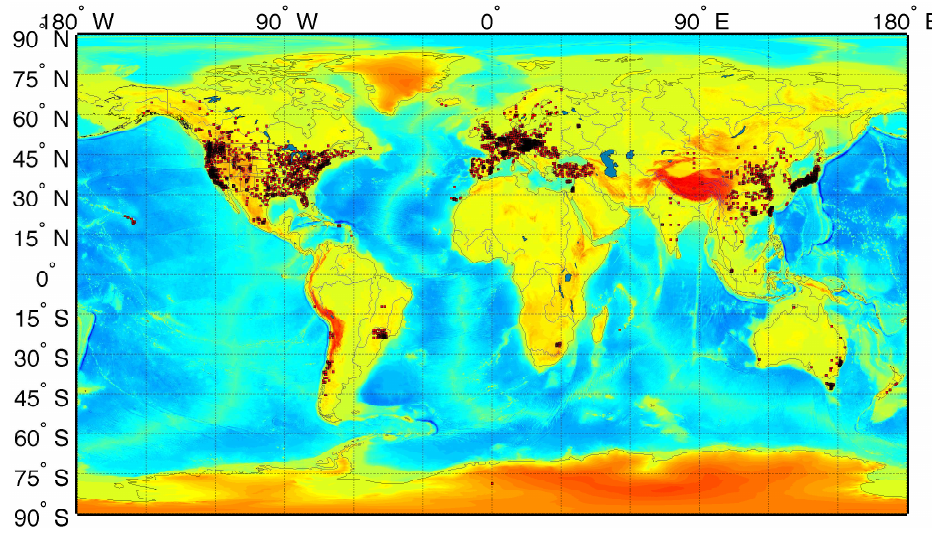
Figure 2. A map showing the 8329 PM measurement site locations from 55 countries 2 . 5 (red squares) that were used over the period 1997–present. The greatest density of sites is in North America, Europe and Asia. However, there are also southern hemisphere sites in South America, South Africa, Australia and New Zealand. The background color scale shows the global topography and